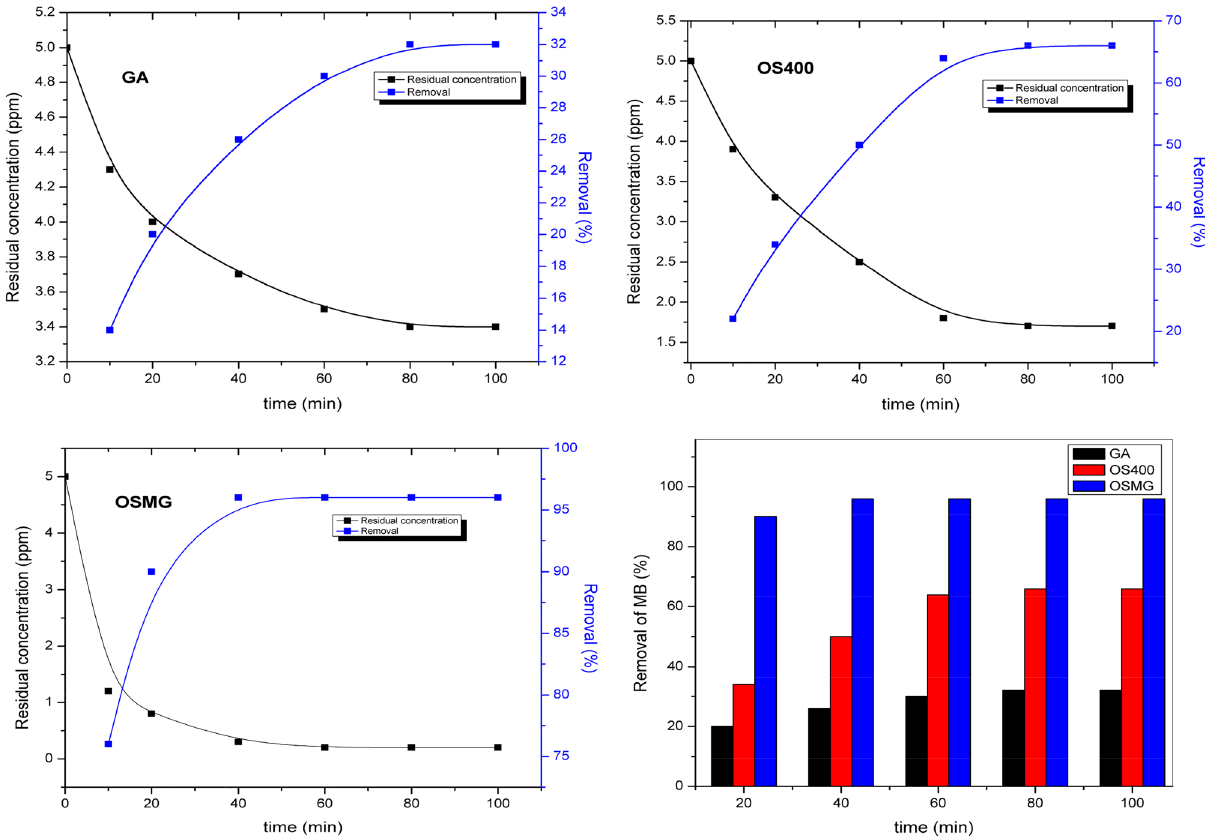
Figure 9. Effect of contact time on the removal percentage of MB